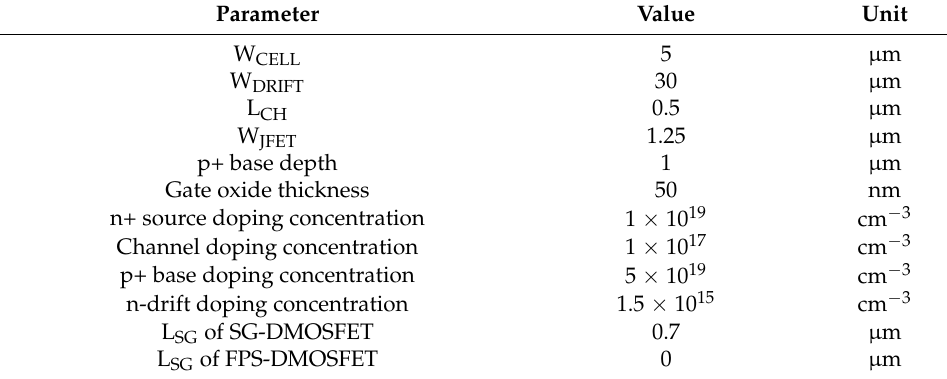
Table 1. Device parameters of the three devices.